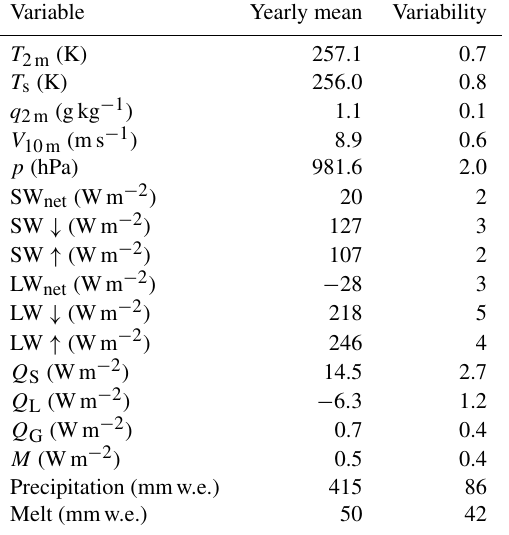
Table 2. Mean annual values and interannual variability (calculated as standard deviations of monthly means) of meteorological vari- ables and SEB components. For precipitation and melt, total annual values are given.